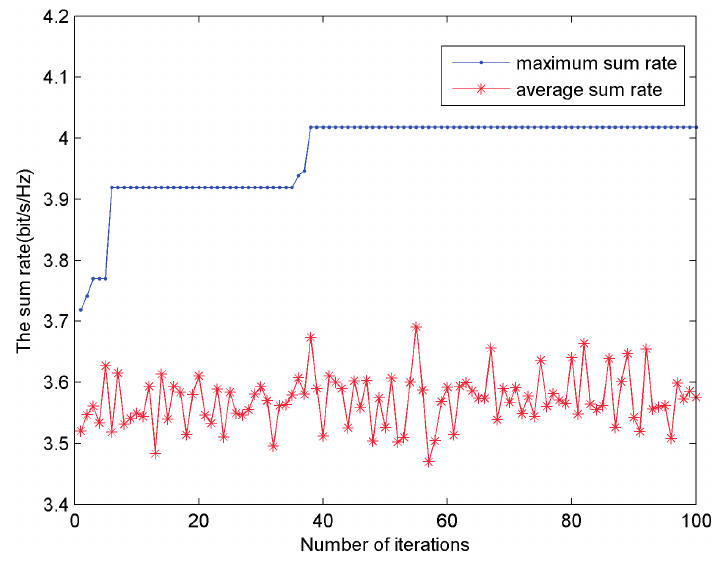
Figure 4. The sum rate versus the number of